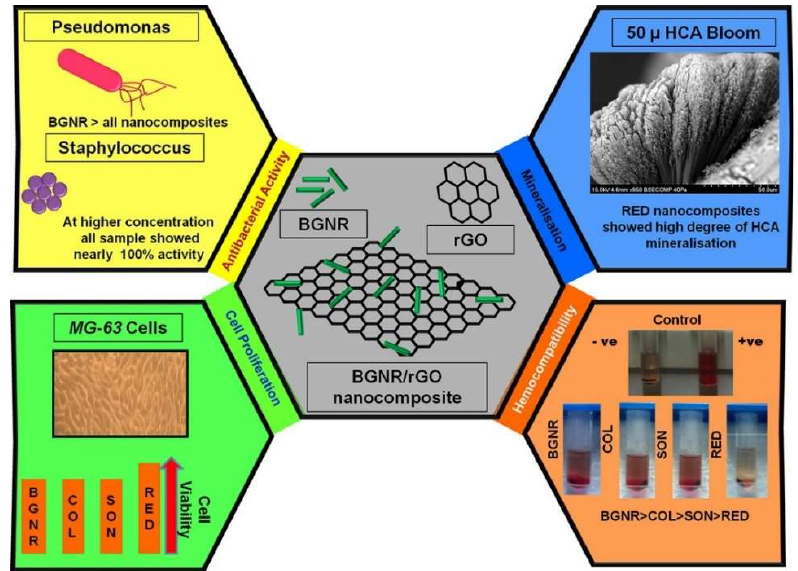
Figure 7. Schematics for HCA formation, antibacterial activity, hemocompatibility, and cell prolif- eration of bioactive glass rods (BGNR) and their composites with rGO (COL, SON, and RED) [297]. Figure also shows the bioactive behavior of the BGNR-rGO composites. It is noticed that the RED composites showed better HCA layer formation, cell proliferation, and hemocompatibility.